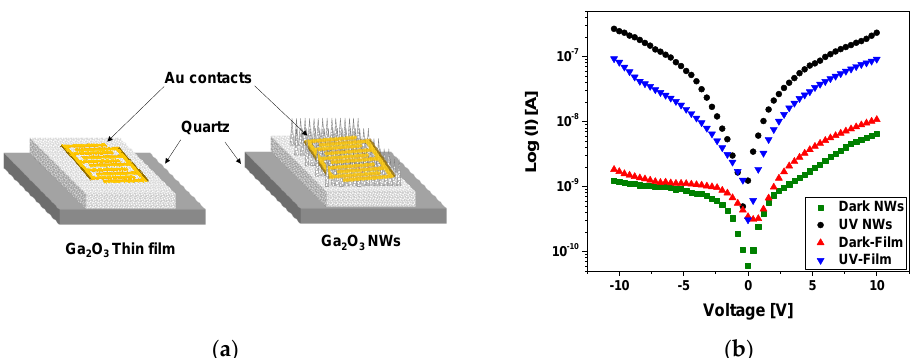
Figure 13. ( a ) Schematic of Au/β -Ga 2 O 3 /Au metal-semiconductor-metal (MSM ) photoconductor of β -Ga 2 O 3 thin film (left) and nanowires (right) on quartz. ( b ) Semi-logarithmic plot of current-voltage for Au/β -Ga 2 O 3 /Au MSM, including β -Ga 2 O 3 thin film and nanowires, versus applied voltage characteristics at 10 V without and with UV illumination at 10 V.